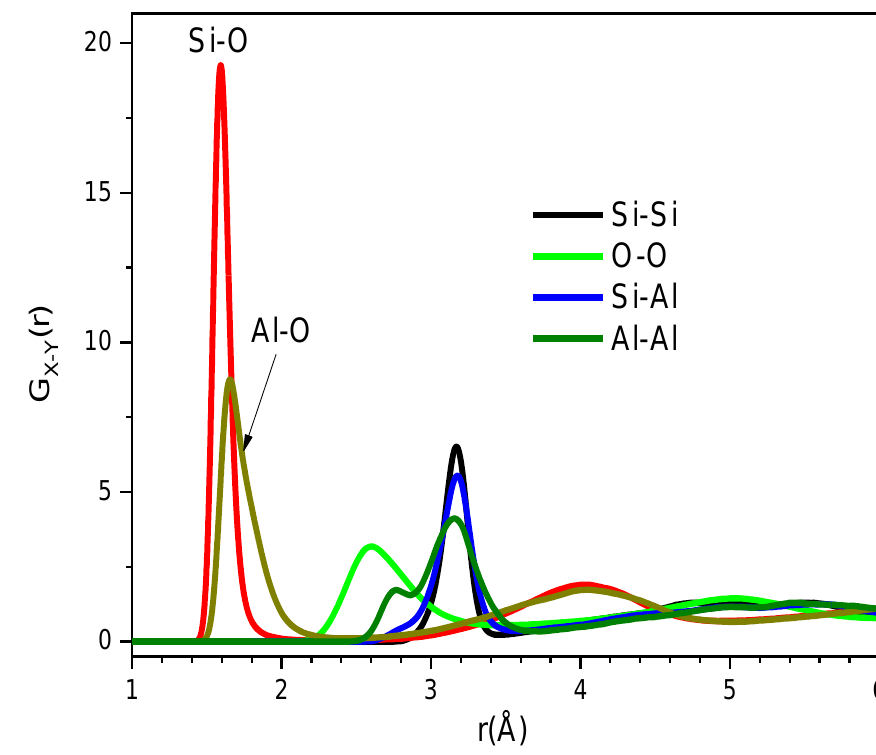
Figure 3. The pair RDFs of Si─O, Al─O, O─O, Si─Si, Al─Al, and Si─Al pairs of AS2 model at ambient pressure and